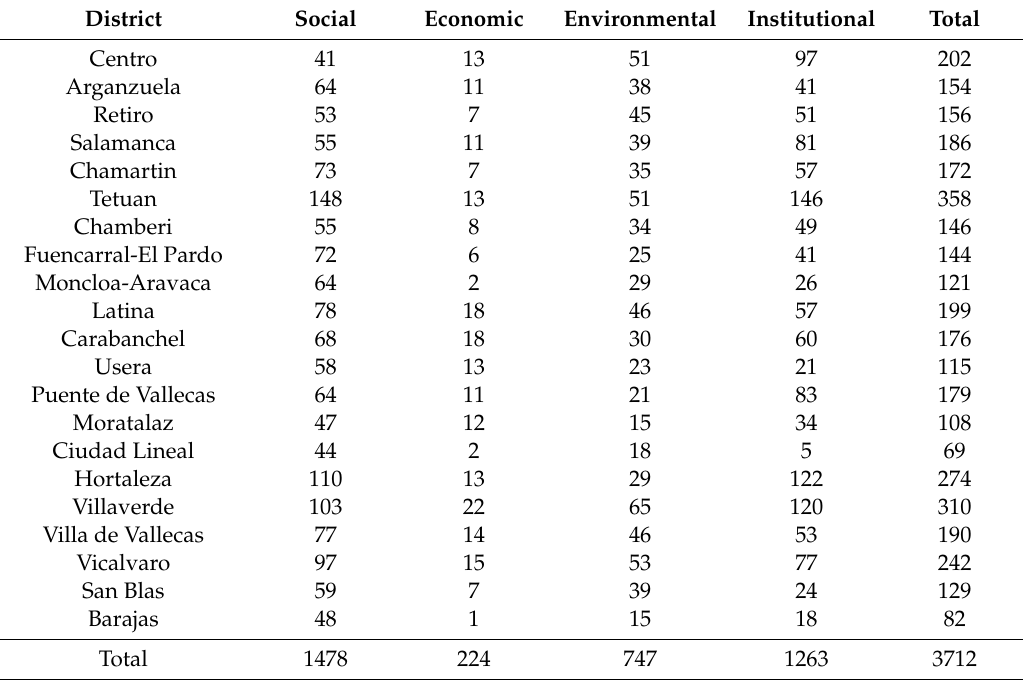
Table 1. Classification of actions regarding the sustainability dimensions (Source: